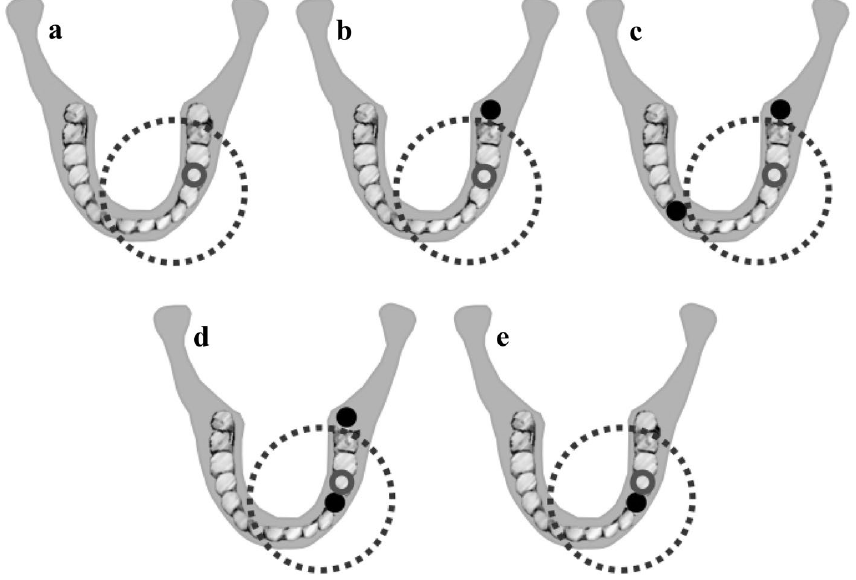
Figure 1. Schematics illustrating the dispositions of the metallic materials in the imaging phantom. The grey circle represents the region of interest (socket of the lower left second premolar), the black dotted circle highlights the limit of the field-of-view and the black solid circle indicates the location of the metallic materials. ( a ) Control (absence of metallic material); ( b ) I Exo—one metallic material in the exomass; ( c ) II